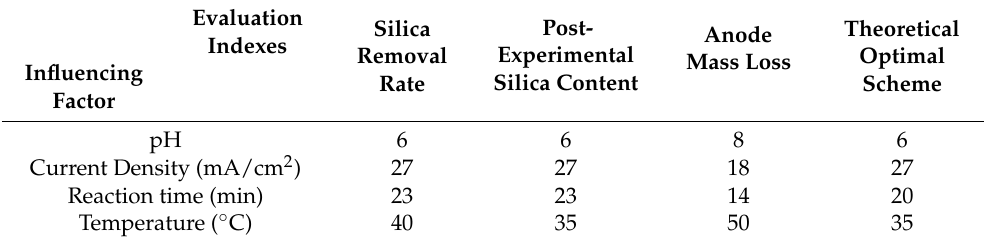
Table 3. Optimal scheme of the orthogonal